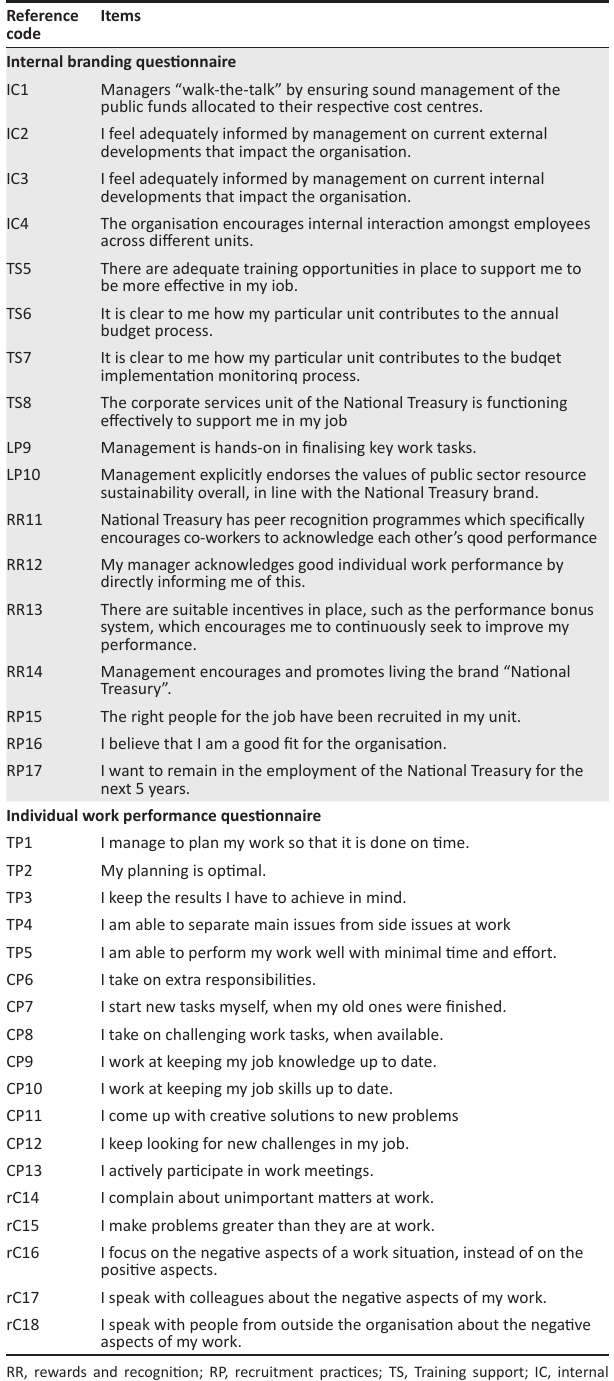
TABLE 2: Summary of questionnaires